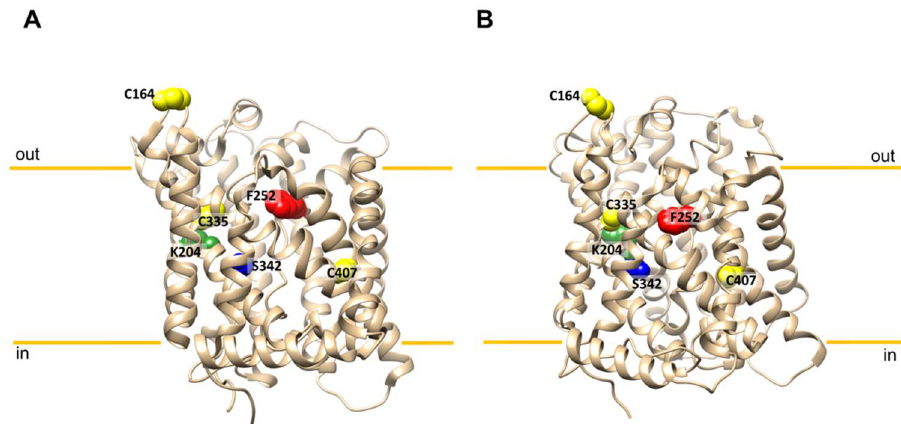
Figure 1. 3D structures of hLAT1. ( A ) The cryo-EM structure of hLAT1 in inward conformation (PDB ID: 6IRT, chain B) was represented as ribbon using Chimera v.1.7 software [18]. ( B ) The cryo-EM structure of hLAT1 in inward conformation (PDB ID: 7DSQ, chain B) was represented as ribbon using Chimera v.1.7 software [18]. C164, C335 and C407 residues are highlighted in yellow spheres, F252 is highlighted in a red sphere, S342 is highlighted in a blue sphere and K204 is highlighted in a green sphere. The cell membrane and its orientation are indicated.